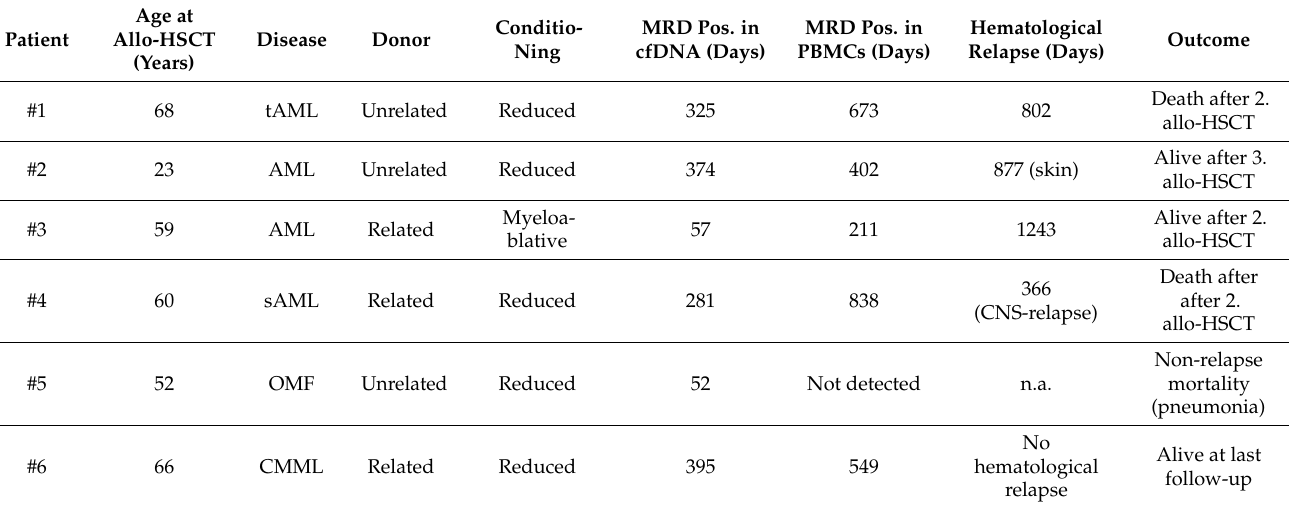
Table 3. Clinical characteristics of patients with MRD positivity in cfDNA before MRD detection in PBMCs after allo-HSCT.